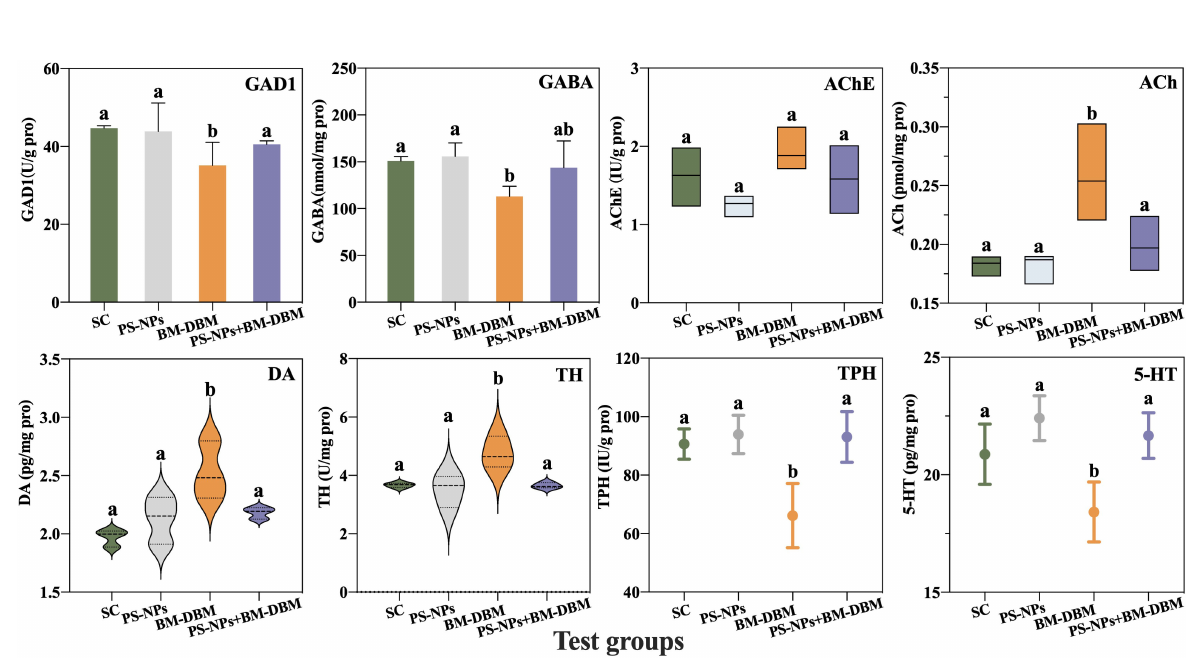
FIGURE 7 Response of different neurotransmitter systems of larvae under BM-BDM and PS-NPs exposure conditions alone or in combination. SC represents the solvent control group. Groups that did not contain the same letter were signi fi cantly different (P <